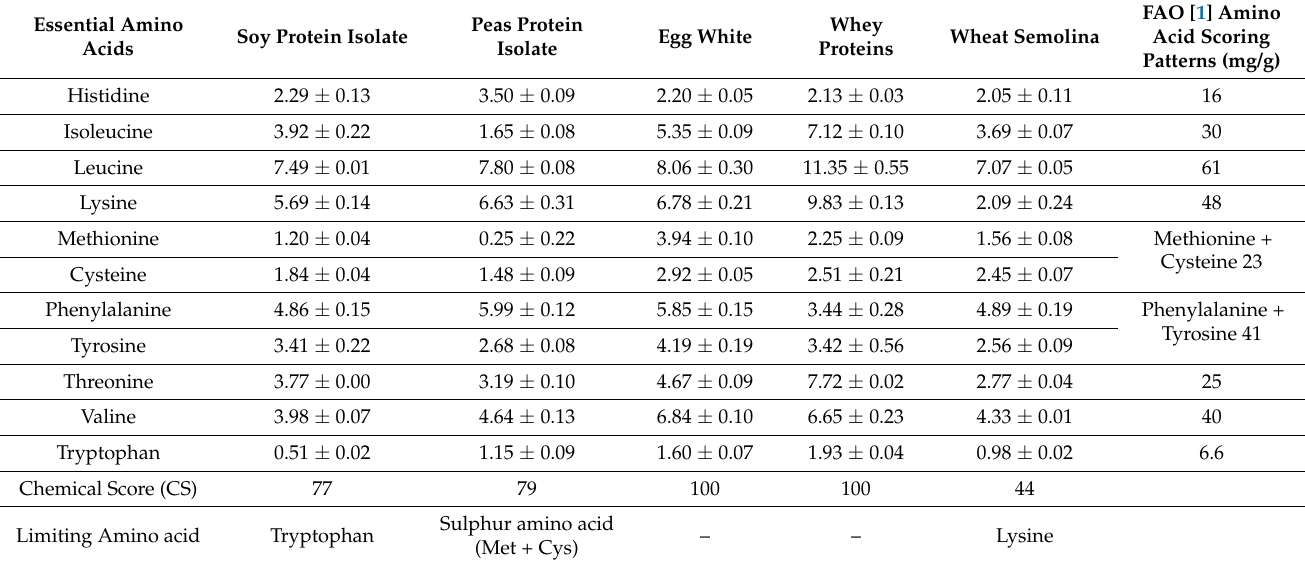
Table 5. Amino acid (g/100 g protein), chemical score (CS) and limiting amino-acid of soy protein, peas protein, egg white, whey proteins and wheat